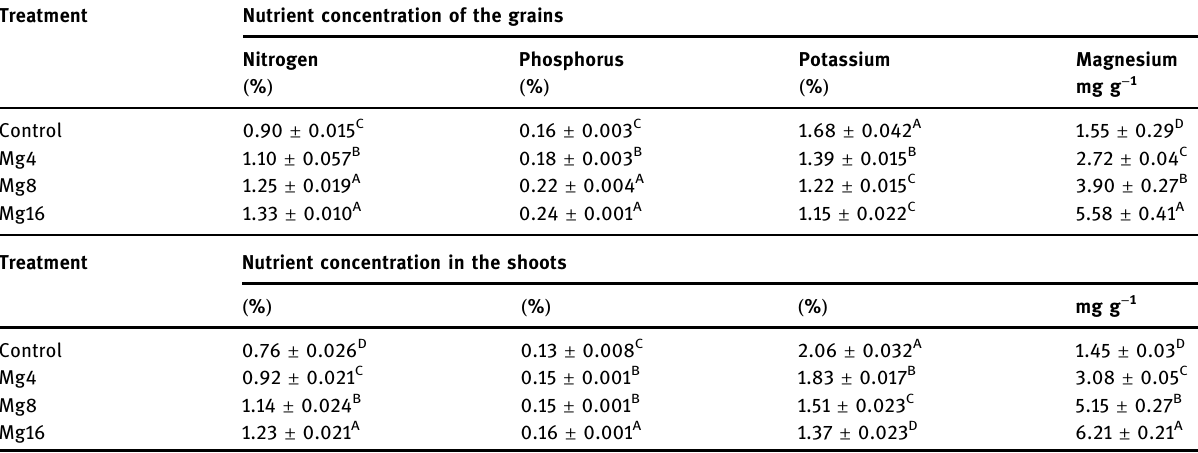
Mean ± standard error of three replicates having di ff erent letters in a column show a signi fi cant di ff erence at p ≤ 0.05 ( Tukey ’ s test ) .